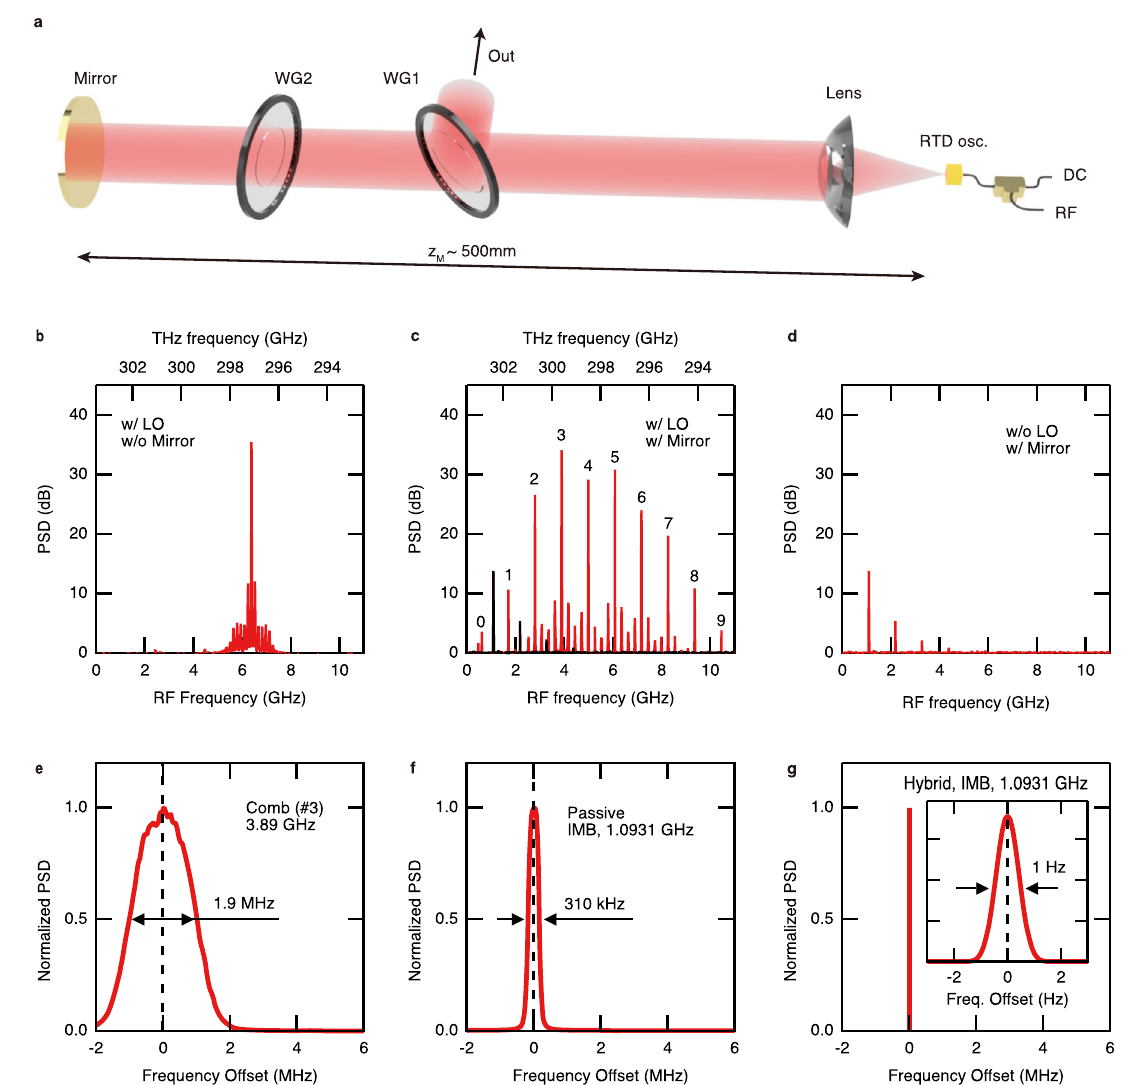
Fig. 1 THz frequency-comb generation in RTD oscillator. a Schematic diagram of the experimental setup. The RTD oscillator is biased with a DC bias voltage and generates a terahertz wave. We applied an external modulation only when we demonstrated hybrid mode-locking. The terahertz emission is split into two beams by the wire-grid polarizer WG1 with a power ratio of 1:1. The beam transmitted by WG1 is re fl ected at the mirror and fed back to the RTD oscillator. The distance between the mirror and the oscillator, z M , is about 500mm. It is tunable with a motorized stage on which the mirror is mounted. The amplitude of the return light is controlled by rotating another wire-grid polarizer, WG2. WG2 is tilted to the beam in order to prevent a direct re fl ection to the oscillator. The beam re fl ected at WG1 enters the measurement part. b Emission spectrum of CW oscillation state observed when the return light was blocked (w/o Mirror) and measured with the local oscillator signal (w/ LO). The left axis shows the power spectral density (PSD) relative to the noise level. The bottom axis shows the heterodyne frequency, and the top axis shows the corresponding terahertz frequency. c Frequency-comb spectrum measured observed under optical feedback (w/ Mirror) and measured with the LO signal. The peaks shown by the black trace were observed even without the LO signal. The numbers at the peaks are the mode indices of the frequency comb. d Emission spectrum of the passive mode-locked state measured without the LO signal (w/o LO). Three peaks are inter- mode beat notes. e Magni fi ed view of a comb line indexed as n ¼ 3. The vertical axis is PSD normalized with the peak height. f Magni fi ed spectrum of the inter- mode beat note (IMB) at 1.0931GHz. g Magni fi ed spectrum of the inter-mode beat note at 1.0931GHz when the bias modulation was applied (hybrid mode- locked state). These spectra were accumulated over 1second. The bias voltage was